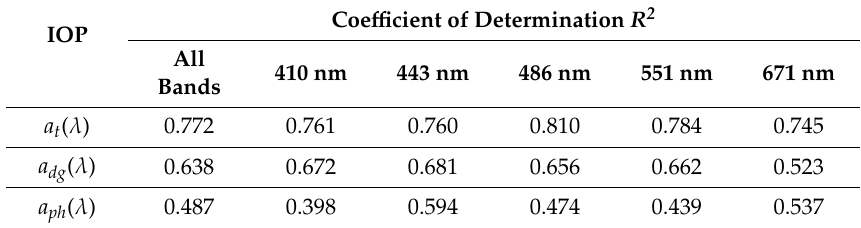
Table 2. Statistics of the ratios with standard deviation (STD) values between the derived- and in- situ-IOPs in Lake Taihu. IOP.